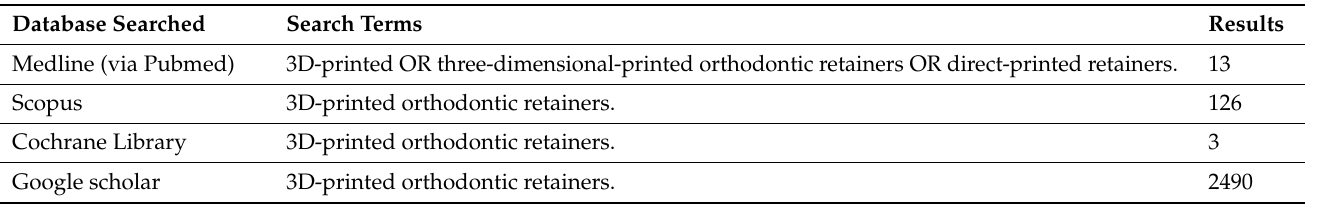
Table 1. Electronic databases searched, the search terms used and the results for each